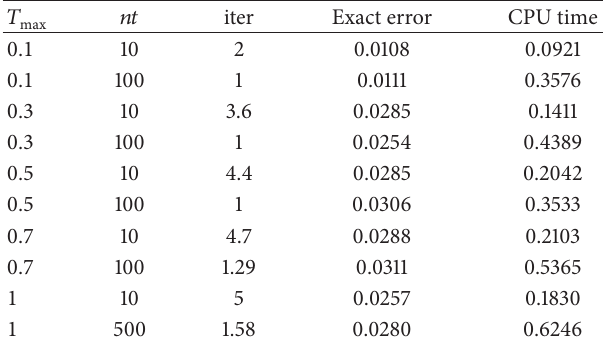
Table 3: Numerical results for CCGT1 and different values of 𝑇 max